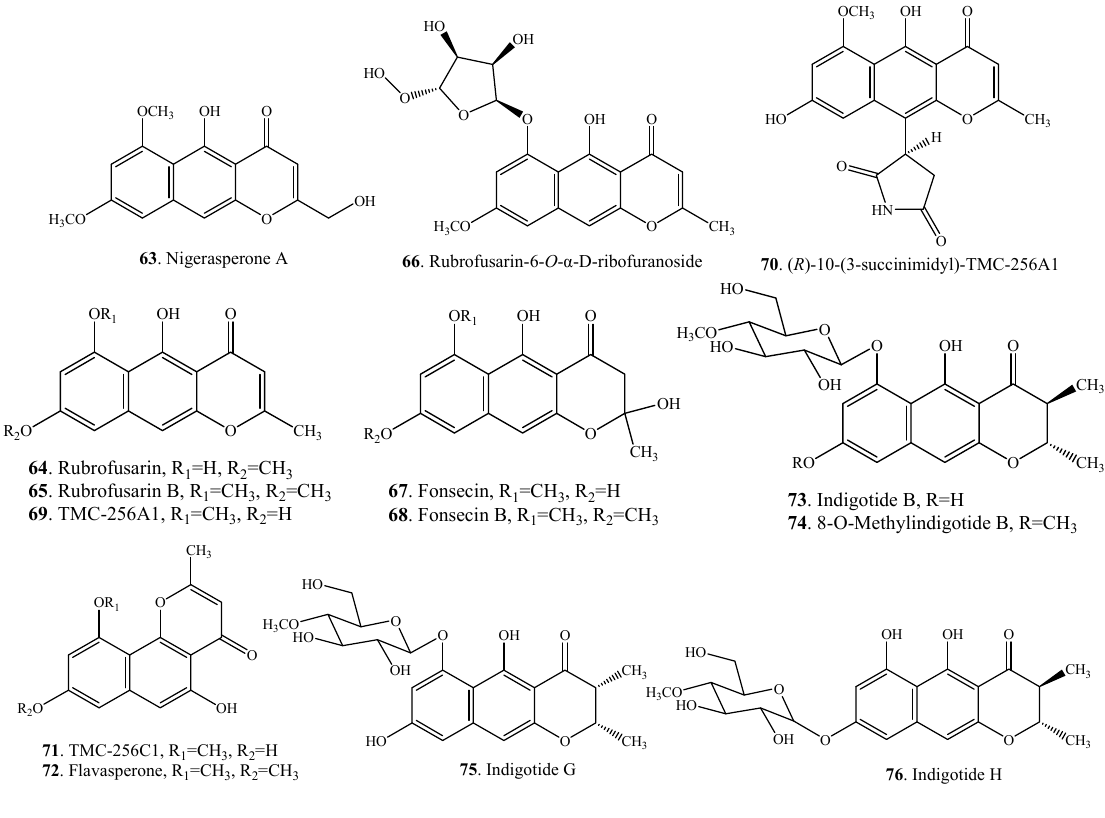
67 . Fonsecin, R 1 =CH 3 , R 2 =H 68 . Fonsecin B, R 1 =CH 3 , R 2 =CH